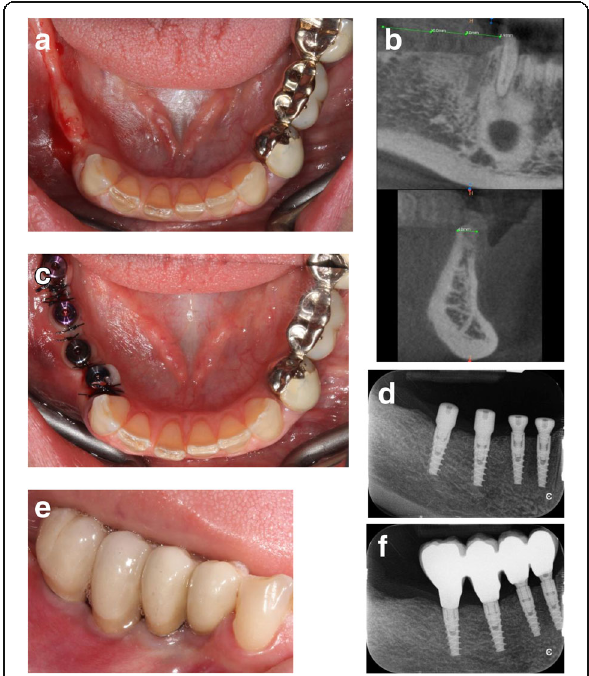
Fig. 2 Case 1: Example of one case involved in the study. a Preoperative view of a partial edentulism in posterior mandible. b Preoperative CT scan. The width of the ridge was 4 mm. c Four narrow diameter implants were placed and left to a nonsubmerged healing. d Baseline periapical radiograph. e Buccal vieew of the final